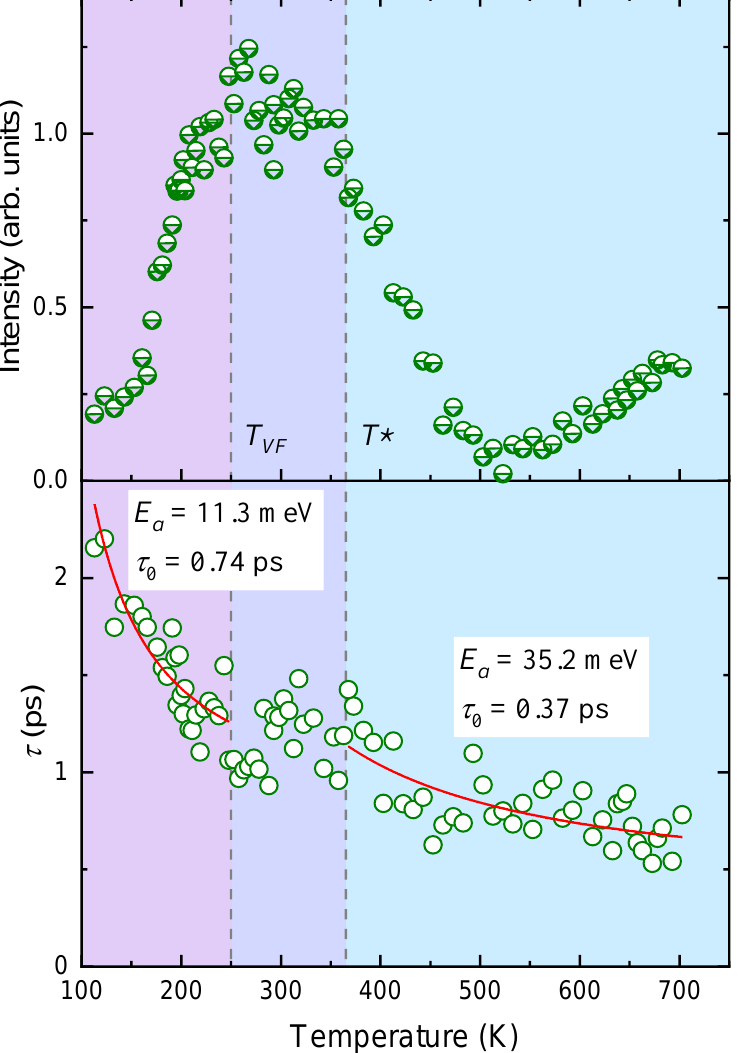
Figure 5. Temperature behavior of the intensity and relaxation time of the broad QELS component in PMN Brillouin spectra with FSR = 800 GHz. The circles are the results of fitting the experimental spectra by Equations (1)–(4); the line corresponds to the approximation of the data using the Arrhenius law. The colors in the figure highlight different temperature regions.